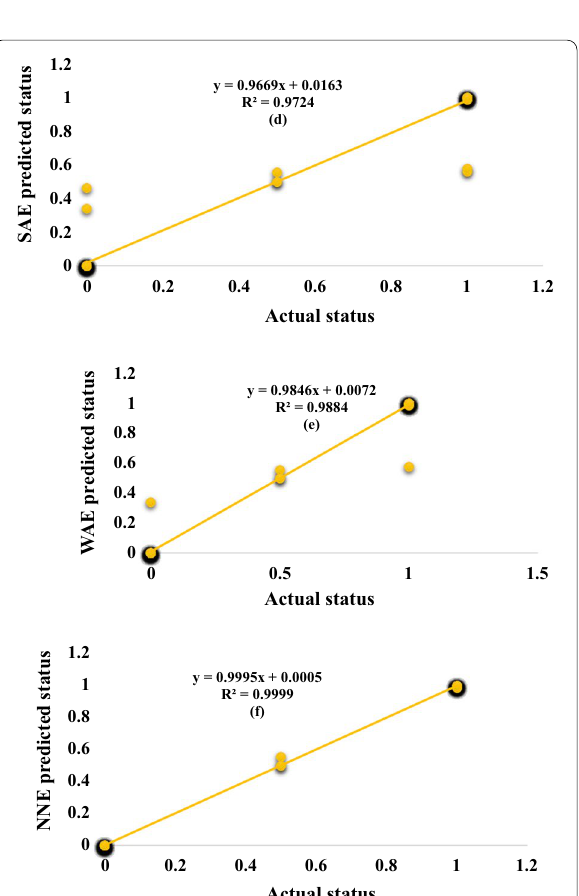
Fig. 8 Scatter plots of the ensemble